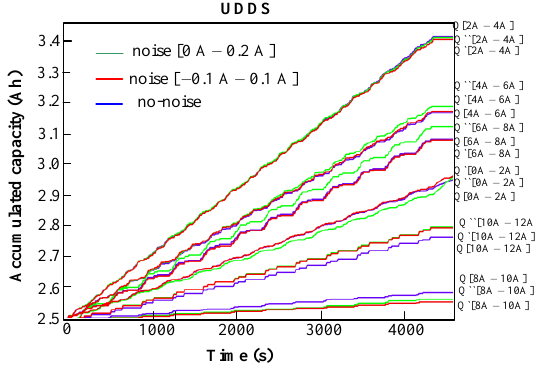
Figure 12. The accumulated capacities in different noisy environments.